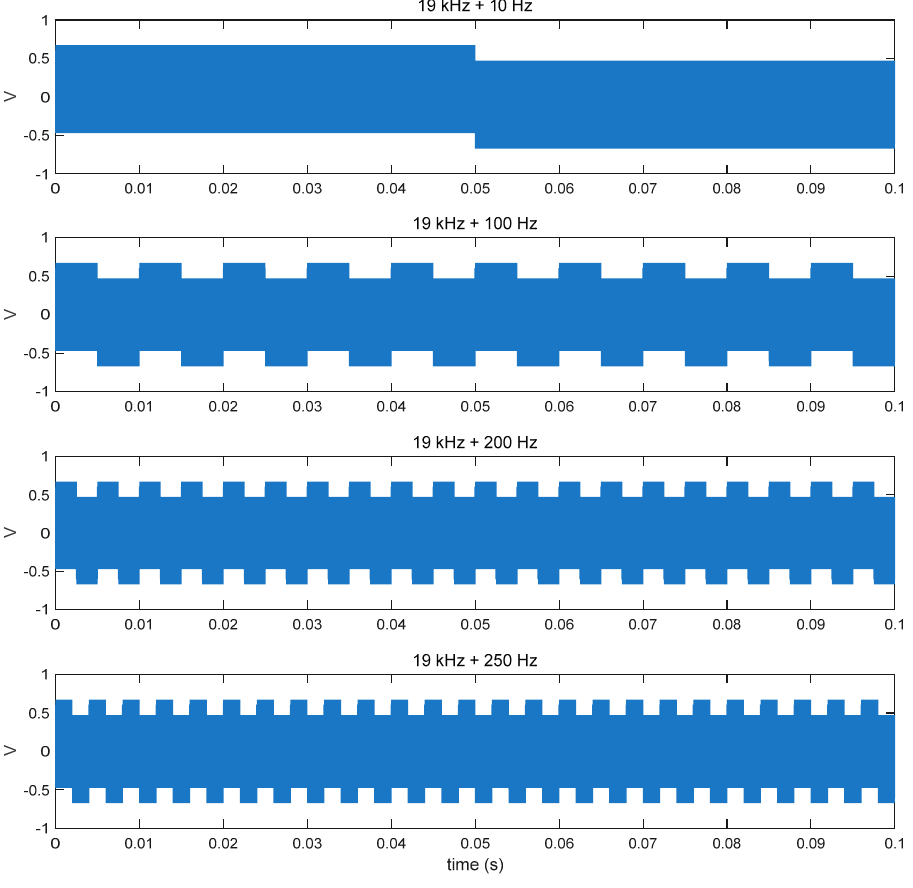
Figure 6. Input signals with additional low frequency vibrations for haptic